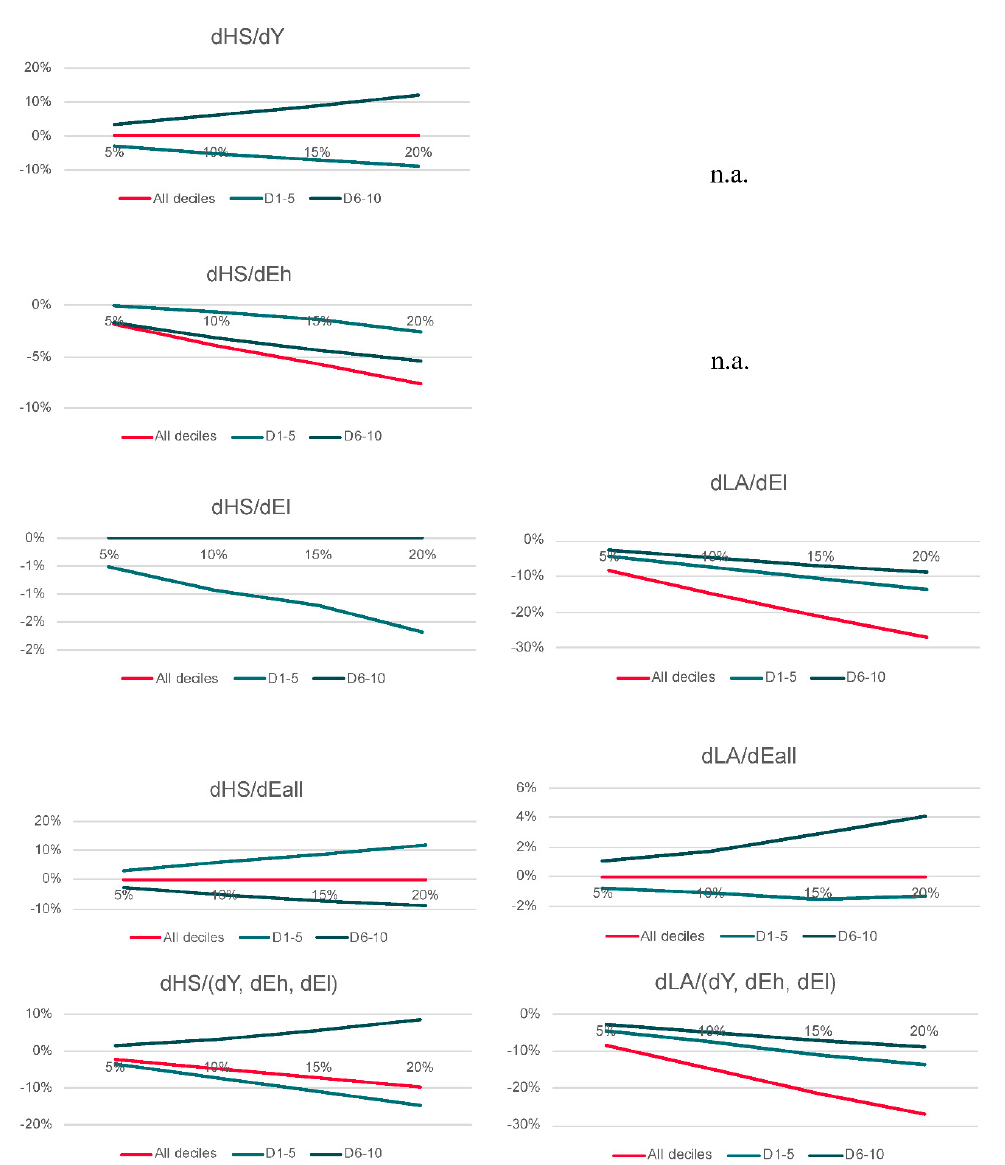
Figure 4. Sensitivities of HS and LA indicators by scenarios and levels of change. Note: for dHS/dE l , “all decile” values equal D1-5 values and are thus hidden behind the green line.